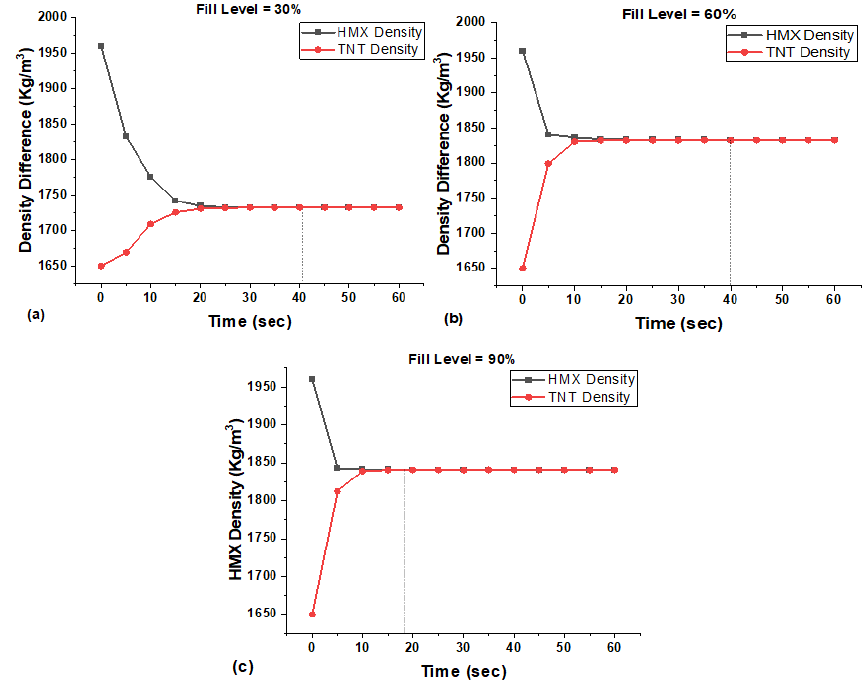
Figure 14. Plots of density difference at ( a ) fill level of 30%, ( b ) fill level of 60%, and ( c ) fill level of 90%.